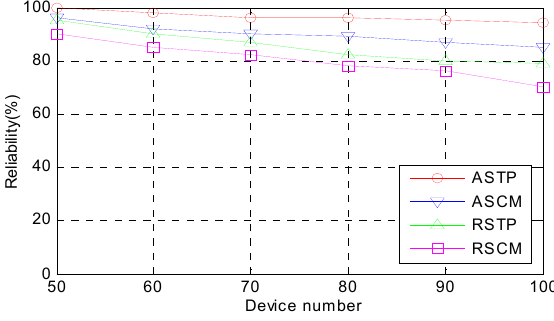
Figure 6. Comparison of the reliability.